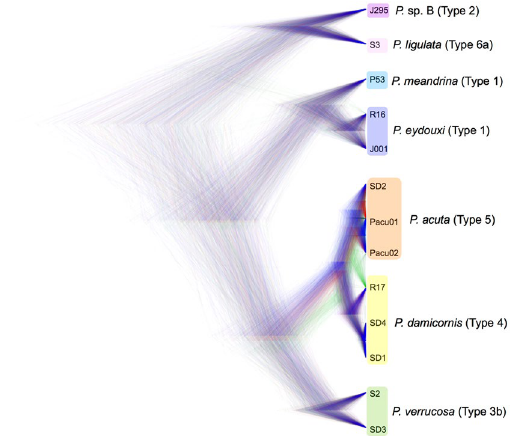
Figure 3. Species tree of Pocillopora . This cloudogram represents the posterior distribution of species trees from the Bayesian phylogenetic analysis program SNAPP using 430 unlinked, biallelic SNPs shared across all Pocillopora taxa. Higher density areas of the tree indicate greater topology agreement. The different colors represent differing topologies; trees with the highest clade credibility are shown in blue and trees represented in green and red represent trees with different topologies. Colored groups in the tree are labeled by the species name most often associated with this clade in the current literature (Table 1). Yellow: Pocillopora damicornis ; orange: P. acuta ; green: P. verrucosa ; light blue: P. meandrina ; dark blue: P. eydouxi ; light purple: P. ligulata ; dark purple: P . sp.